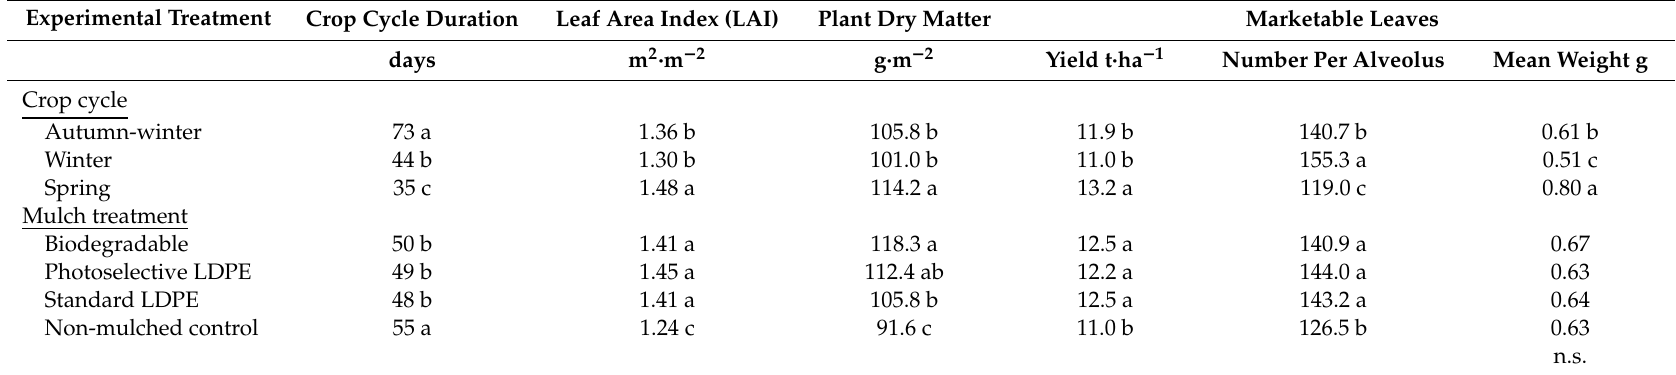
Table 1. Mean values of perennial wall rocket precocity, growth indices and yield components as a ff ected by crop cycle and mulch